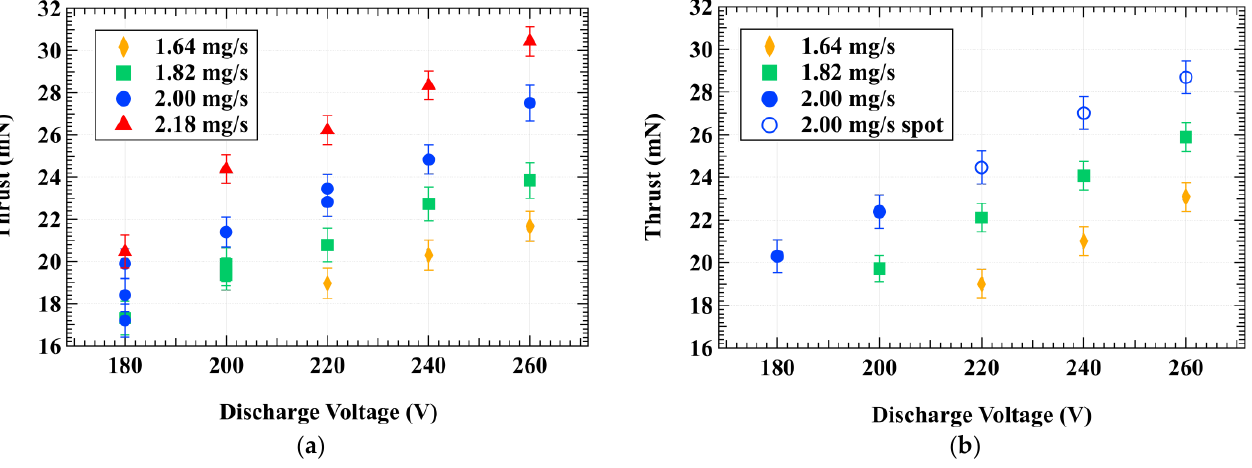
Figure 6. Thrust as a function of discharge voltage and anode mass flow rate from ( a ) the 5-s tests and ( b ) the 15-s tests.